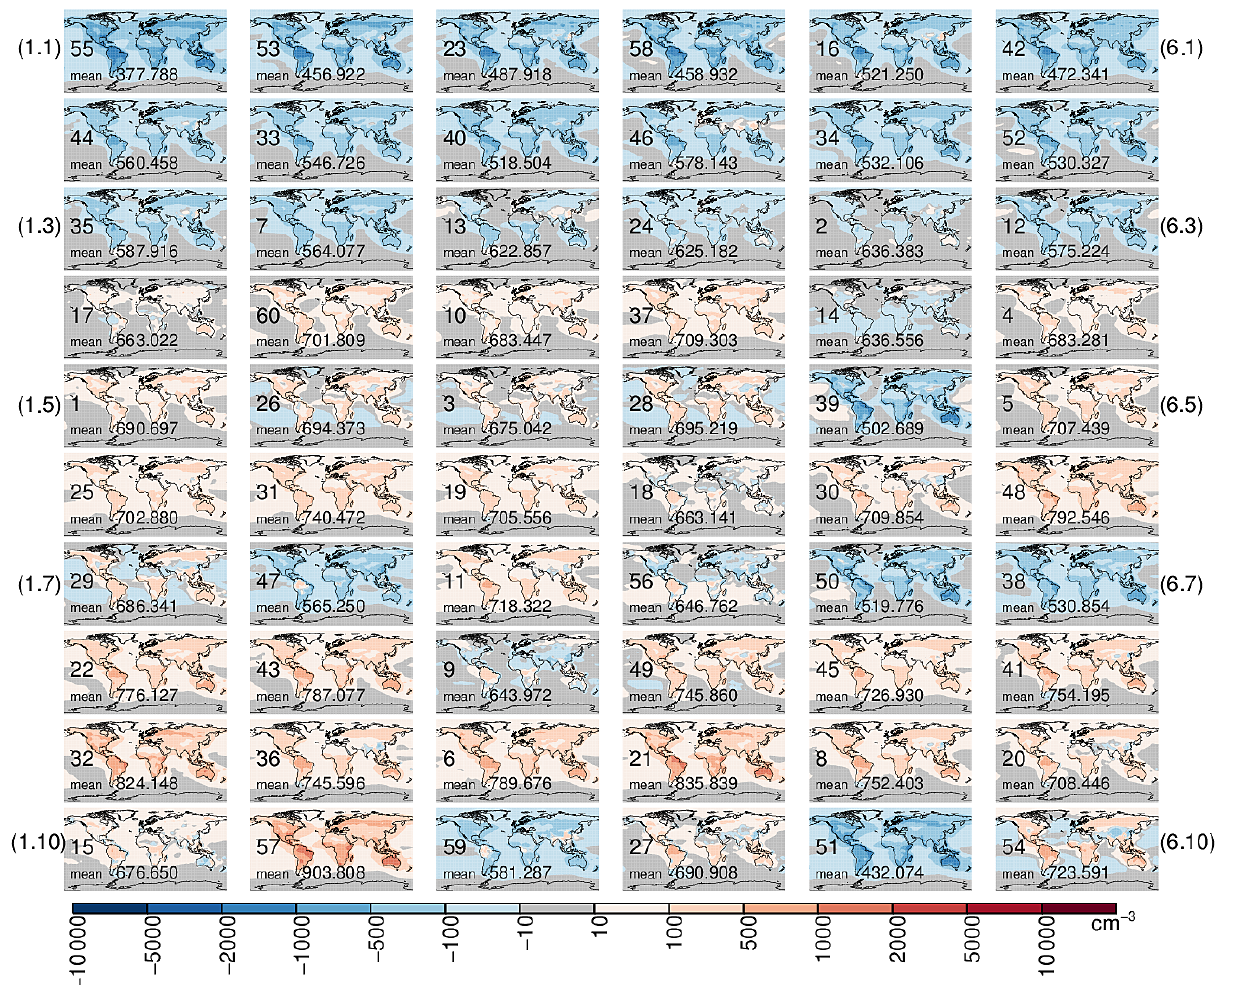
Figure 6. Global annual mean anomaly of N50 number concentration at the surface (cm − 3 ) produced within the ensemble. Each subplot shows the anomaly of an ensemble member (numbered between 1 and 60) from the ensemble mean N50. The global mean N50 is given on each subplot. The subplots are arranged in order of increasing global mean